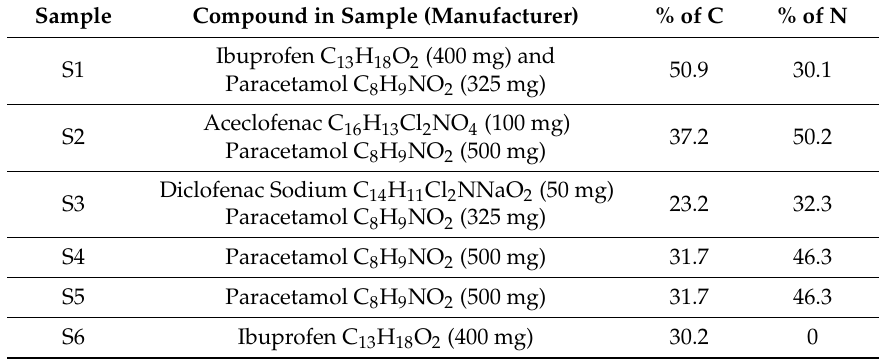
Table 1. Sample details along with molecular formula and total weight % of carbon and